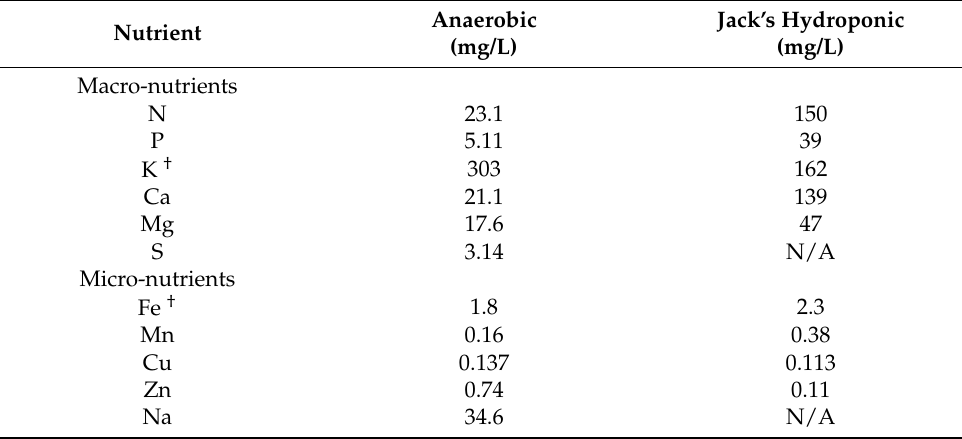
Table 5. Hydroponics solution comparison. Plant available concentrations of nutrients after AT com- pared to recommended concentrations for hydroponic lettuce and leafy green production (fertilizer information retrieved from jrpeters.com, accessed on 15 October 2020).